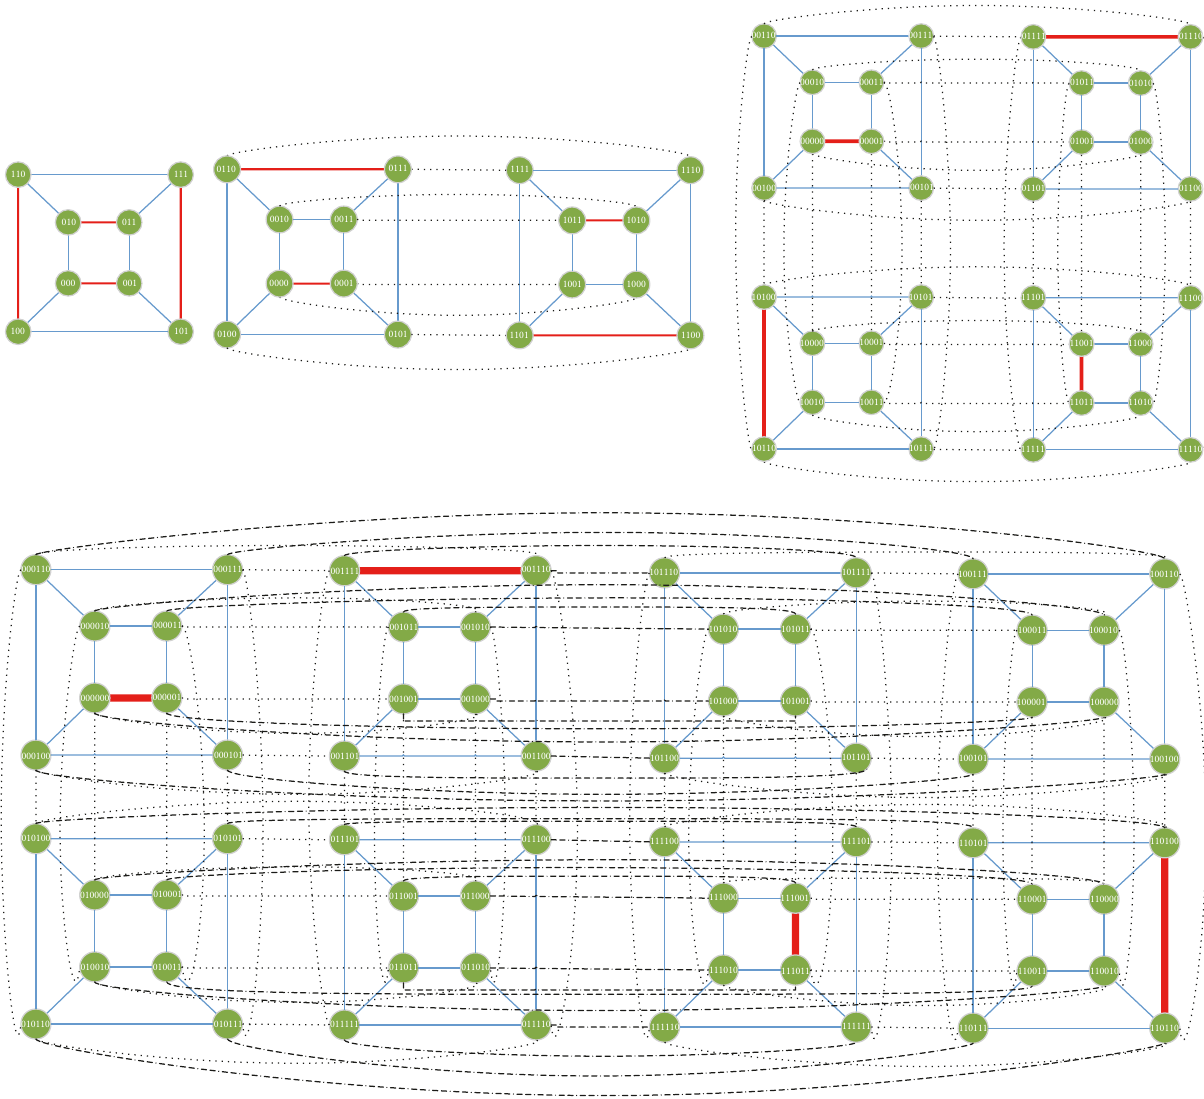
Figure 7: The proposed candidate in 𝐻 𝑛